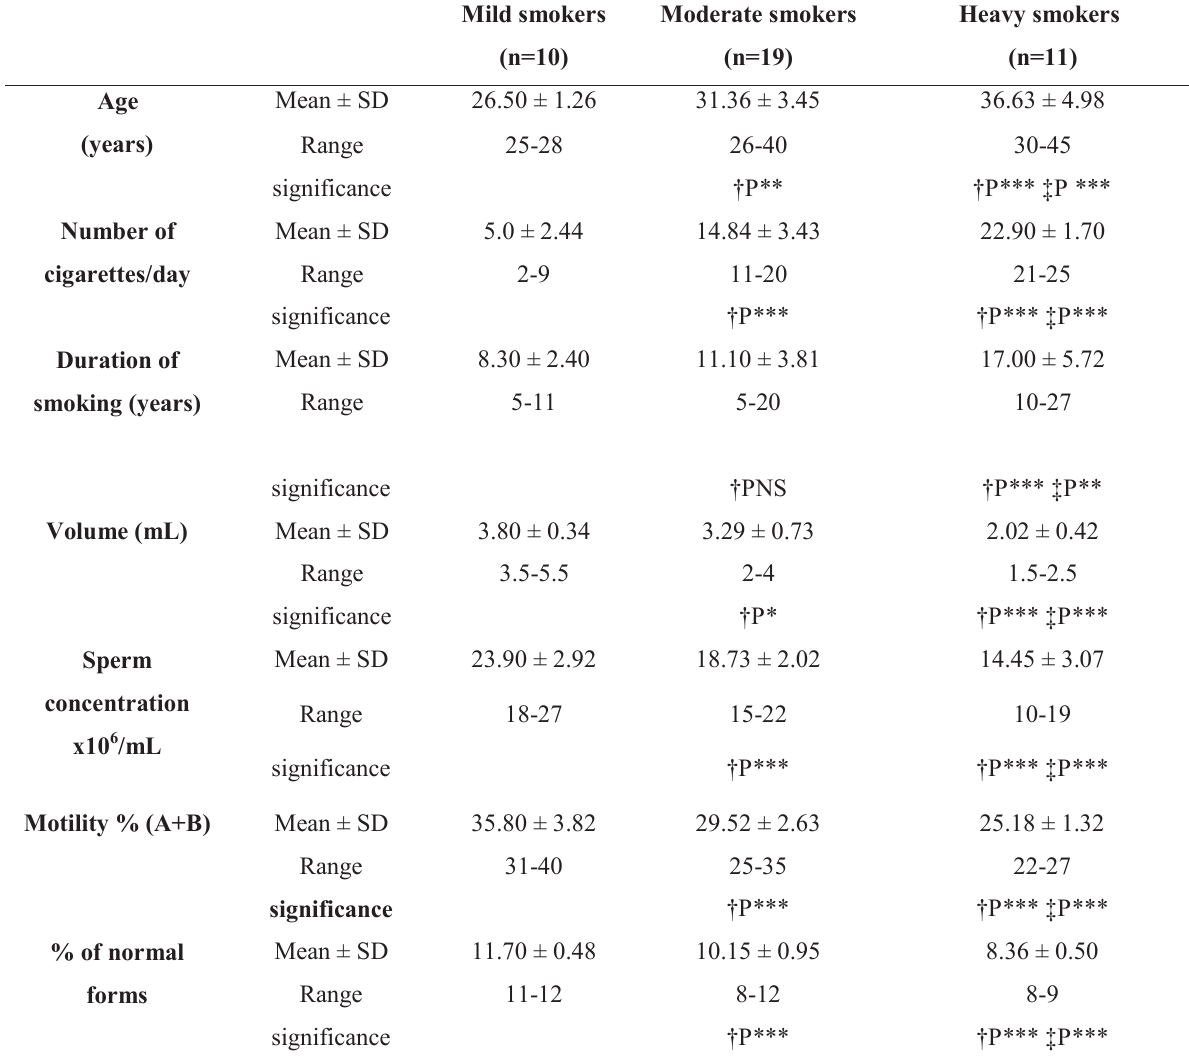
Table 3 - Demographic variables and semen parameters in infertile men according to smoking status.